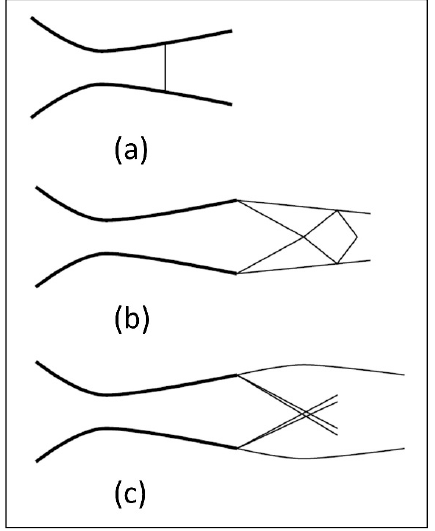
Figure 16. Flow regimes: ( a ) unprimed nozzle flow; ( b ) over-expanded flow; ( c ) under-expanded flow [107].